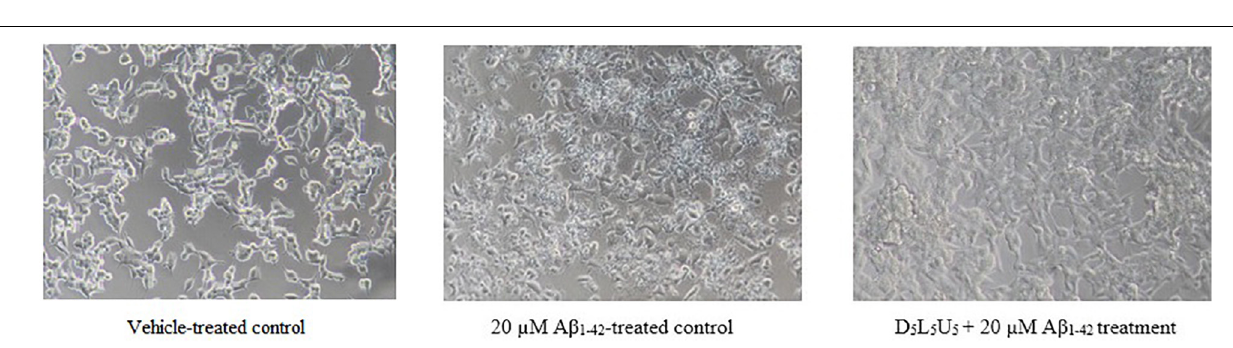
FIGURE 5 | BE(2)-M17 cell morphology for vehicle-treated control, A β 1 - 42 -treated control and the D 5 L 5 U 5 treatment. Comparison of cells for 20 µ M A β 1 - 42 -treatment with and without D 5 L 5 U 5 pre-treatment. The BE(2)-M17 cells are pre-treated with D 5 L 5 U 5 followed by exposure of 20 µ M A β 1 - 42 for 72 h. Cell morphology was imaged using a Nikon phase-contrast microscope